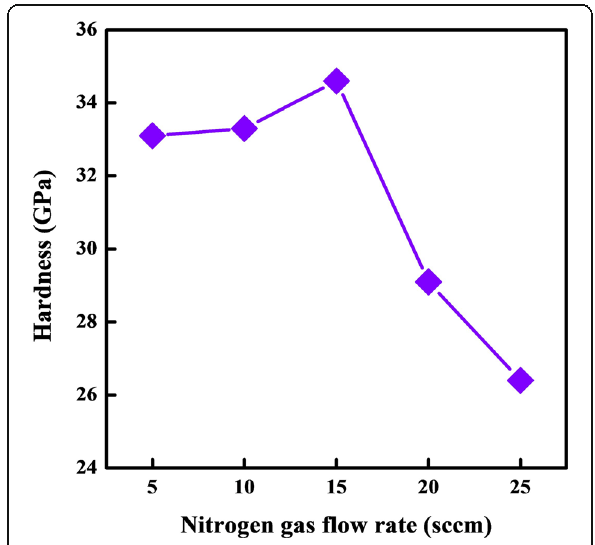
Fig. 5 Hardness of Ti-Al-N films deposited at different nitrogen gas flow